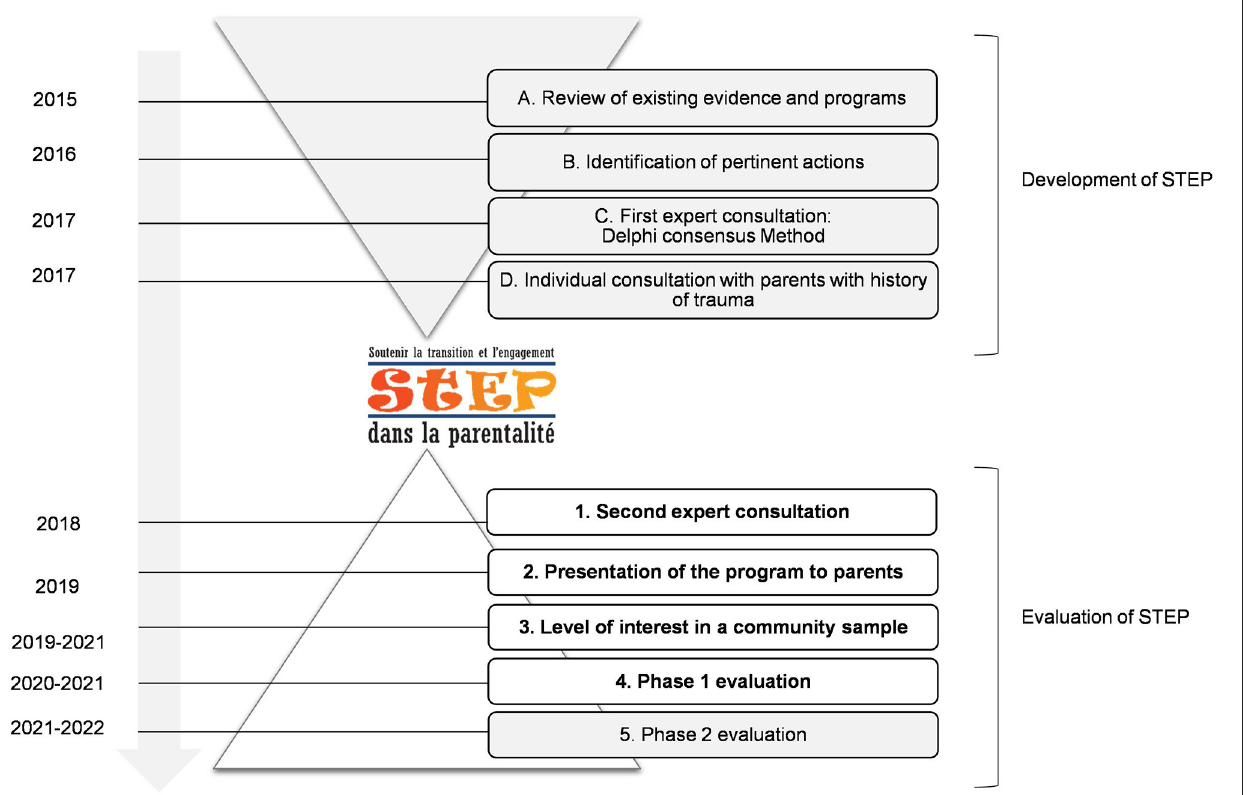
FIGURE 1 | Timeline of the development and evaluation of STEP. In the current study, results of phases 1–4 are